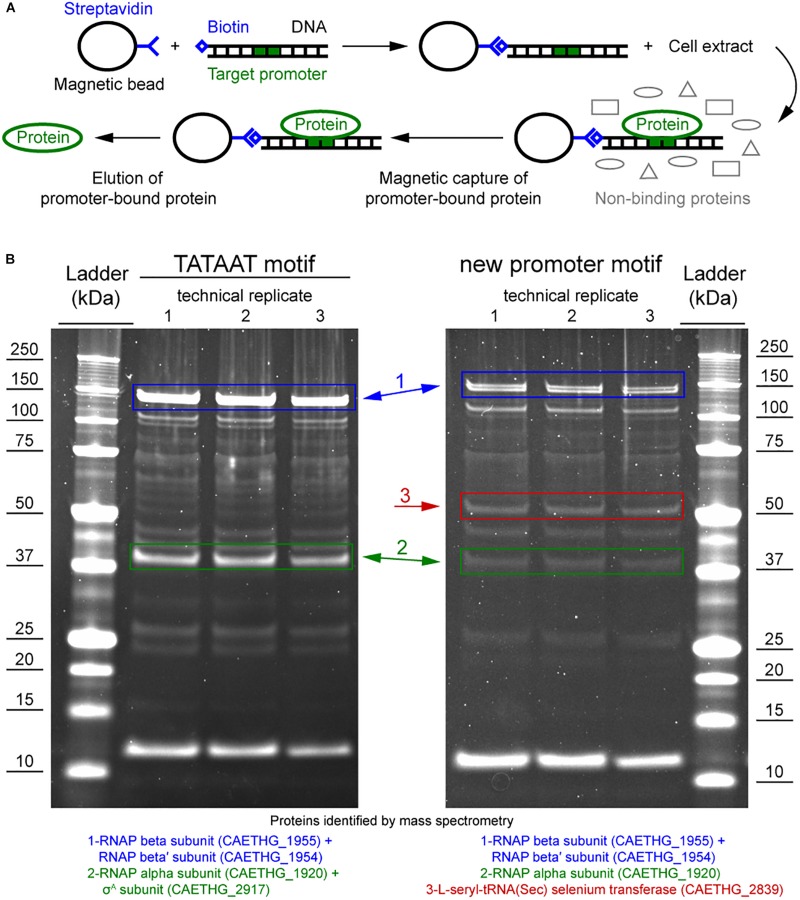
DNA-protein binding assay shows specific binding of C. autoethanogenum RNAP subunits and a selenium transferase to the Pcauto. (A) Overview of the DNA-protein binding assay (i.e., the promoter pull down/DNA affinity chromatography method, Jutras et al., 2012). (B) Separation of proteins specifically bound to the TATAAT motif (for gene CAETHG_3424) or the Pcauto (for gene CAETHG_1617) with gel electrophoresis and identification using mass spectrometry. The alpha and beta subunits of the RNAP (CAETHG_1920 and 1954-55) were successfully identified for both the Pcauto (CAETHG_1615 and CAETHG_1617) and the TATAAT motif control. Technical replicate denotes replicate of the DNA-protein binding assay (A) (data not shown for CAETHG_1615).